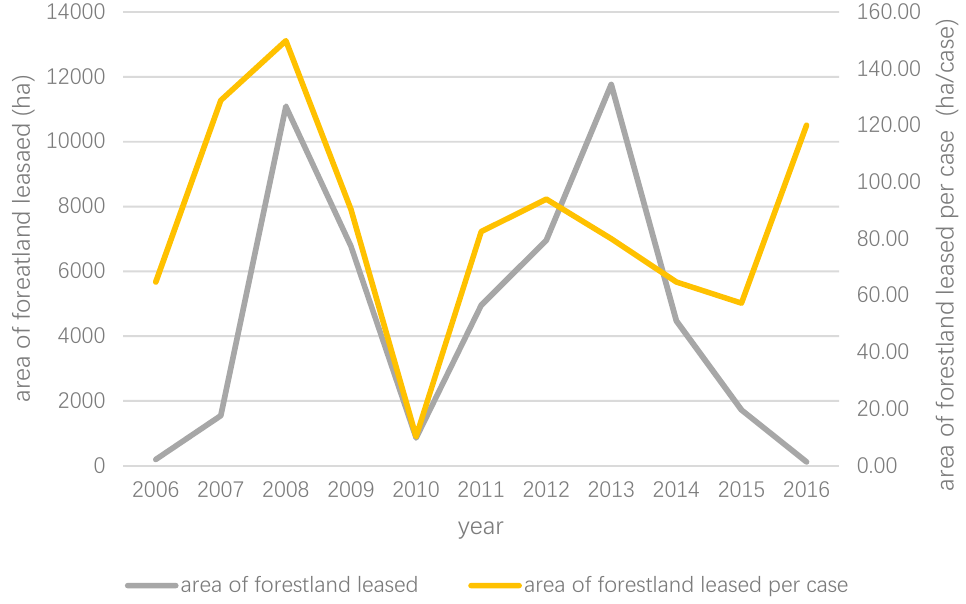
Figure 1. Dynamics of leased forestland with areas per case larger than 10 hectares.